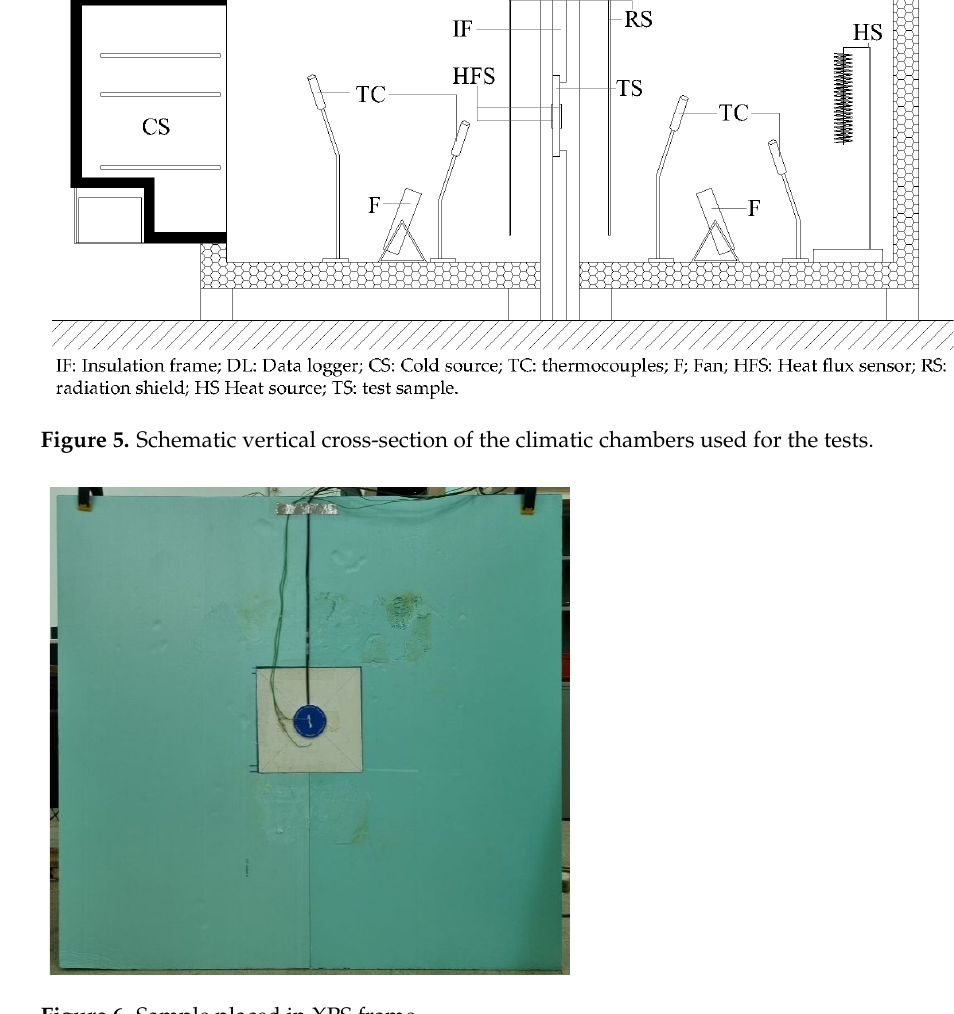
Figure 5. Schematic vertical cross-section of the climatic chambers used for the tests.